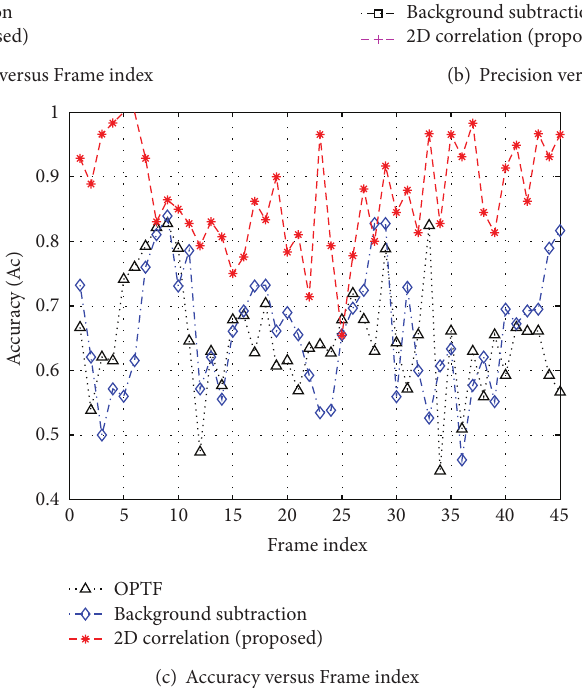
Figure 8: Comparative analysis of frame based surveillance metrics on “Dog1” data